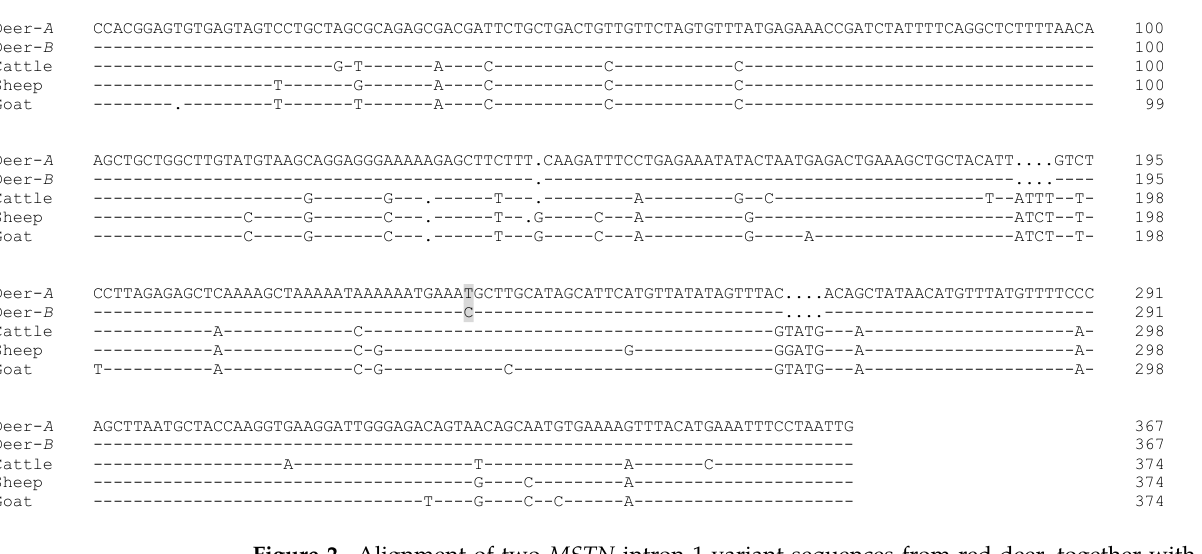
Figure 2. Alignment of two MSTN intron 1 variant sequences from red deer, together with the representative sequences reported in cattle, sheep, and goat. The variant sequences represent two unique PCR-SSCP patterns shown in Figure 1 and labelled as Deer- A and Deer- B , with the nucleotide difference between these two variants being shaded. The sequences exclude the PCR primer-binding sequences. The cattle, sheep, and goat MSTN sequences were retrieved from GenBank with accession numbers AB076403, DQ530260, and EF591039, respectively. Dashes represent nucleotides identical to the top sequence and dots are introduced to improve the alignment.